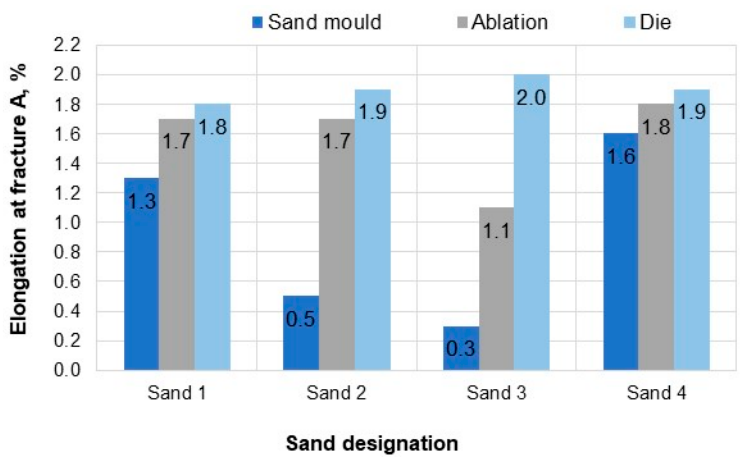
Figure 12. Elongation at fracture A of the tested samples.